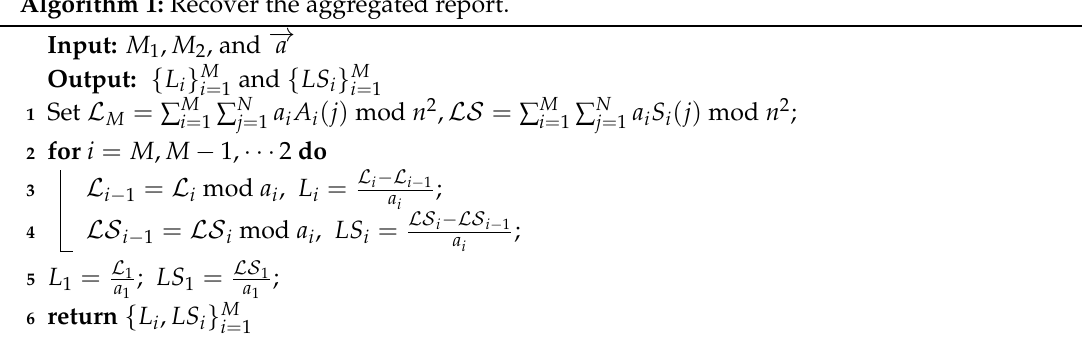
Algorithm 1: Recover the aggregated